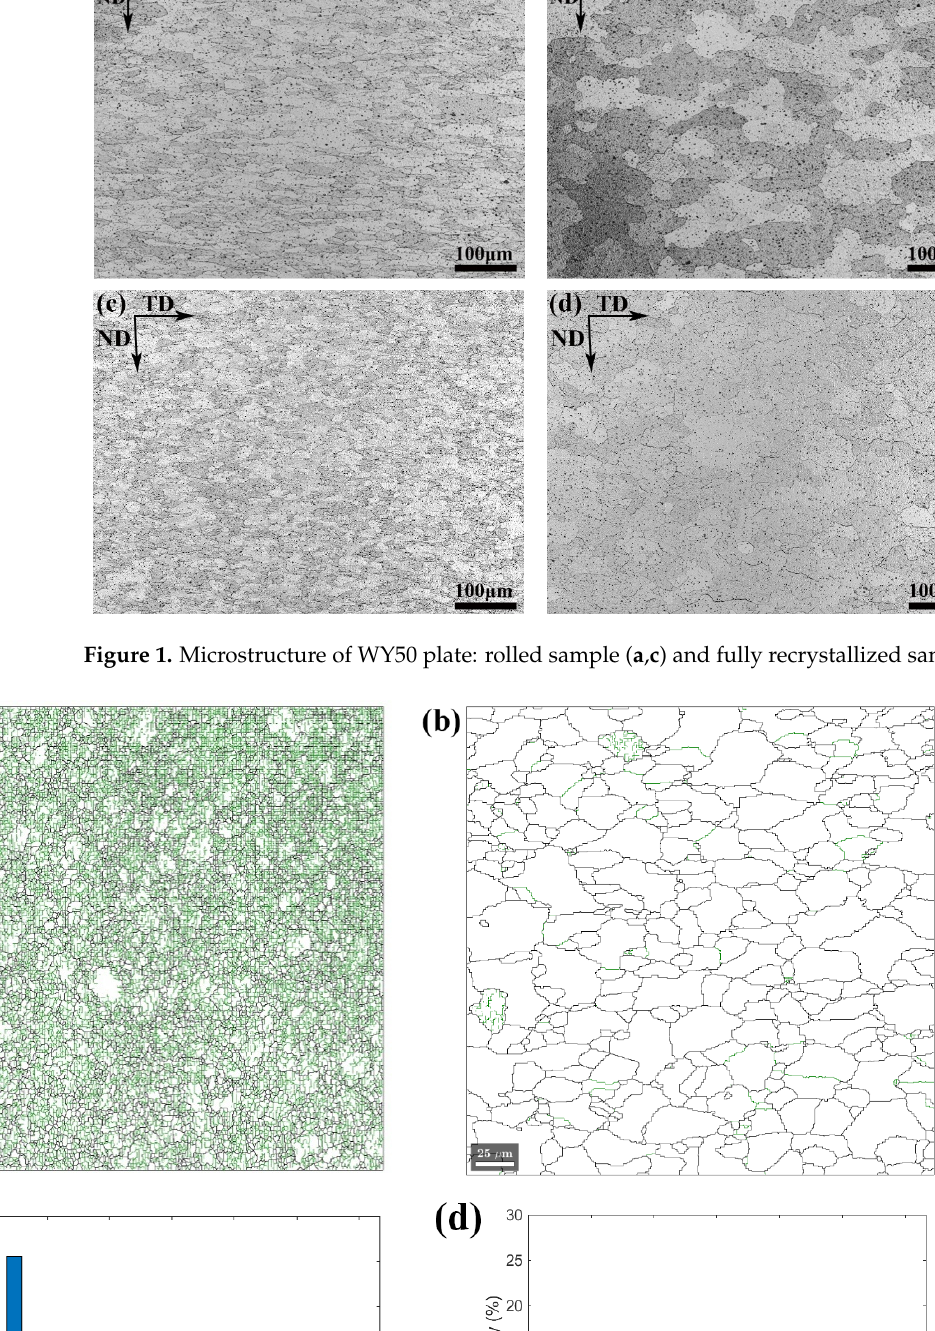
Figure 1. Microstructure of WY50 plate: rolled sample ( a , c ) and fully recrystallized sample ( b , d ).